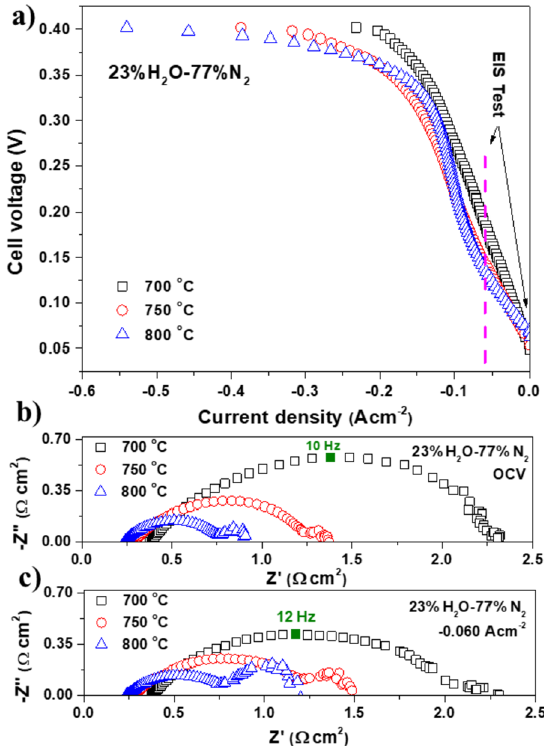
Fig. 4 a i-V curves and EIS measured at b OCV, and c − 0.060 A/cm 2 conditions in the temperature range of 700–800 °C with an interval of 50 °C for symmetrical cell with a cell configuration of SFM-SDC/ LSGM/SFM-SDC operated at 23%H 2 O–77%N 2